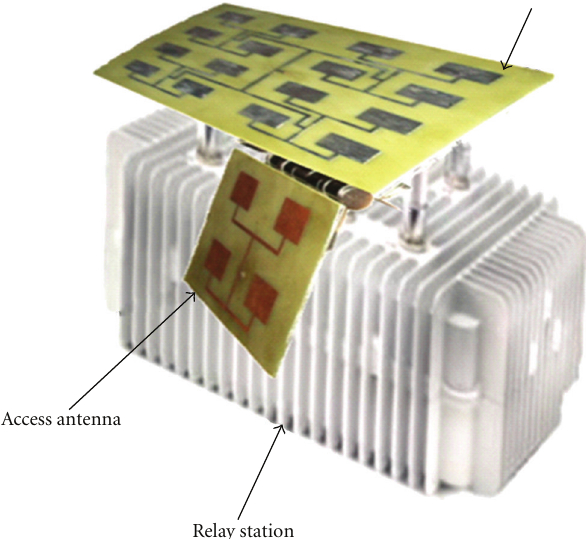
Two configurations are presented for which measured and simulated S 21 are given. Coupling ( S 21 ) is investigated against the angle between the antenna planes for the two configura- tions. Maximum values of S 21 against ω were presented for the frequency range of 3.4 to 3.6 GHz in which the antennas operate. Coupling is typically below − 40 dB. Diagrams of S 21 against ω show that coupling increases with increasing angle.